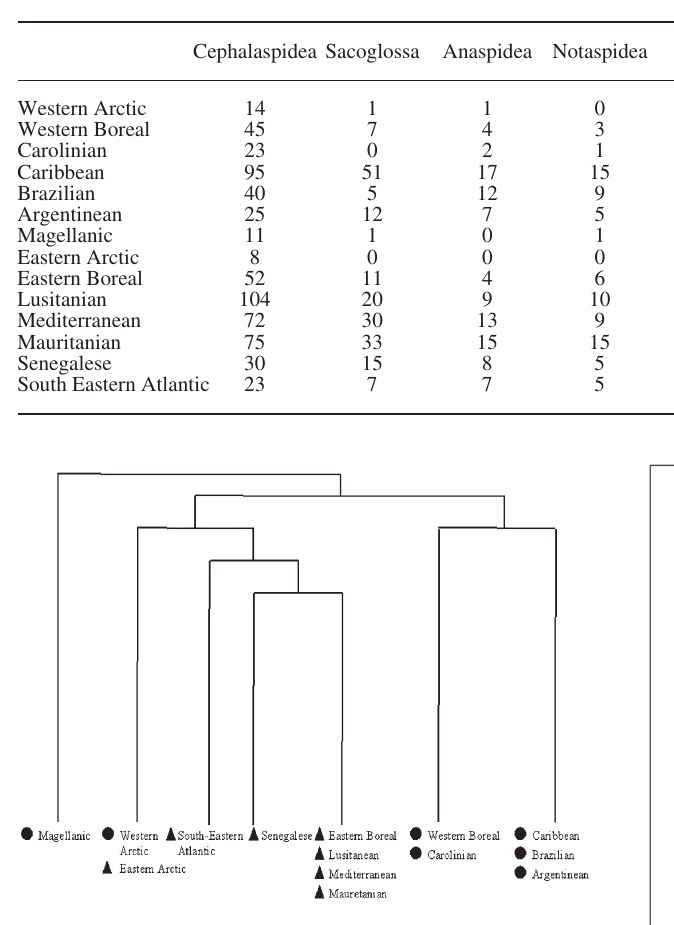
Table 1. – Total number of species according to Order or Suborder for each zoogeographic area.